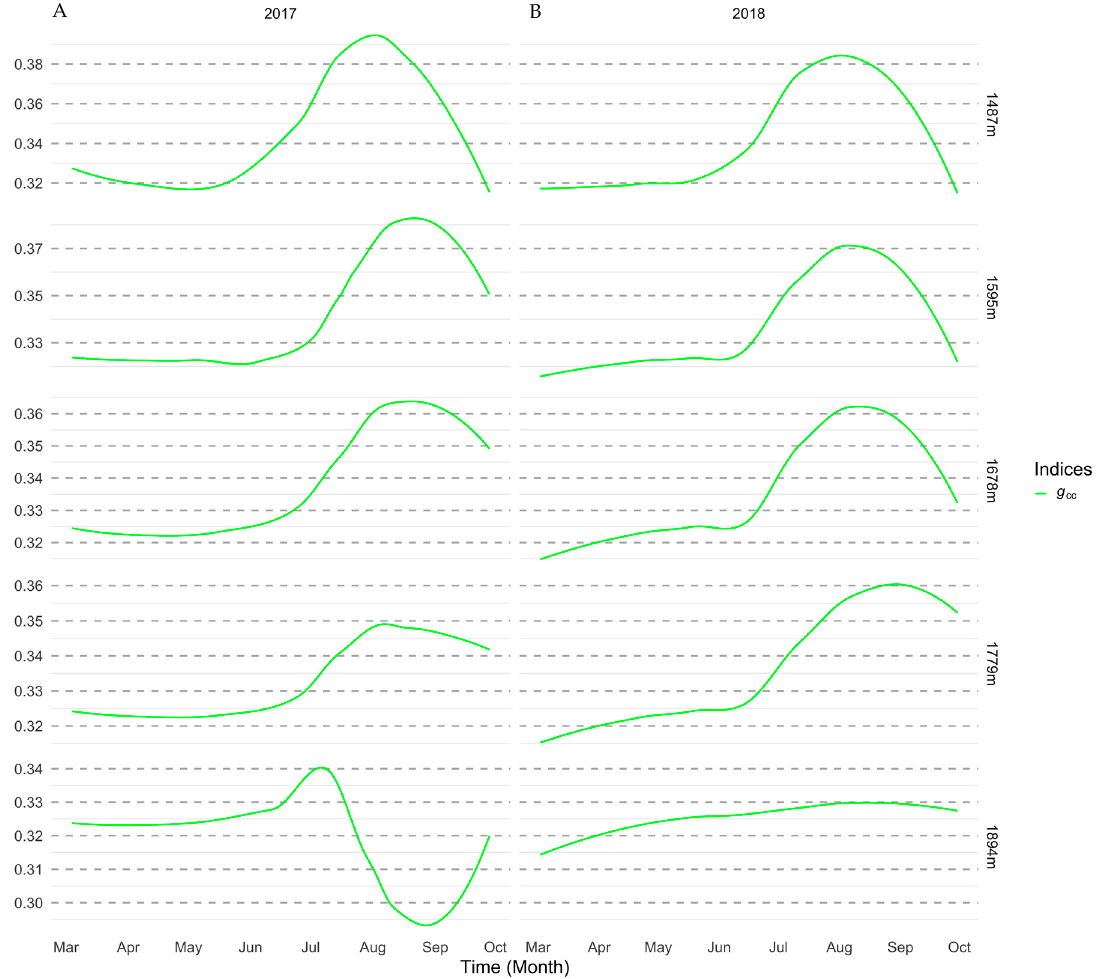
Figure A5. Green Chromatic Coordinate ( g cc ) that is a proxy of greenness calculated using Sentinel reflectance as data existed after August for years 2017–2018, showing the decline in green-up around late August but moderated by elevation. ( A ) 2017, capturing the ramp-up after late June right after snow-melt and decline after August; highest elevation sites have very short green-up. ( B ) Similar patterns as 2017, 2018 shows ramp-up in greenness around late June and drop in greenness after August.